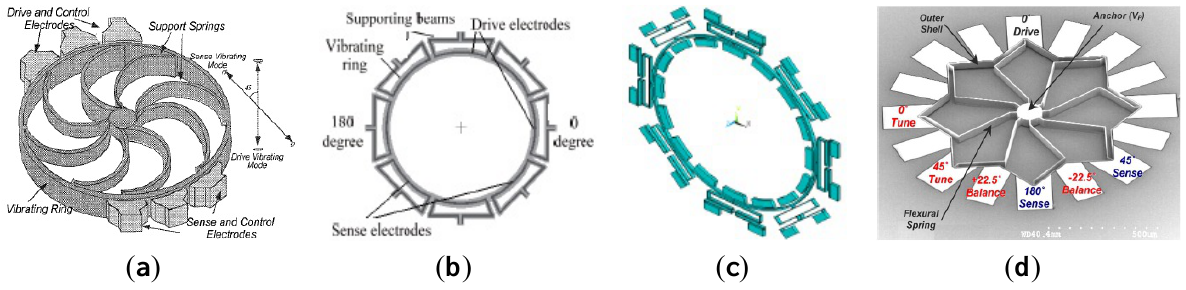
Figure 6. Various VRGs. ( a ) University of Michigan VRG. ( b ) and ( c ) Chinese Academy of Sciences VRG. ( d ) Georgia Tech